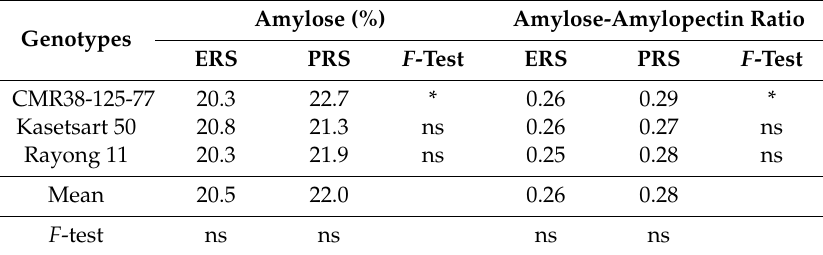
Table 4. Amylose, amylose-amylopectin ratio of starch isolated from storage roots of three cassava genotypes at final harvest in early rainy seasons (ERS) and post rainy seasons